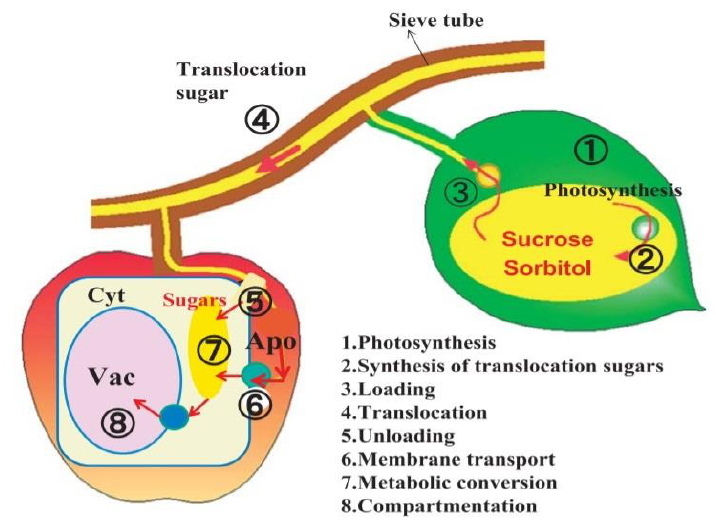
Figure 2. Movement of photoassimilate from the leaf to the fruit. Adapted with permission from Yamaki,